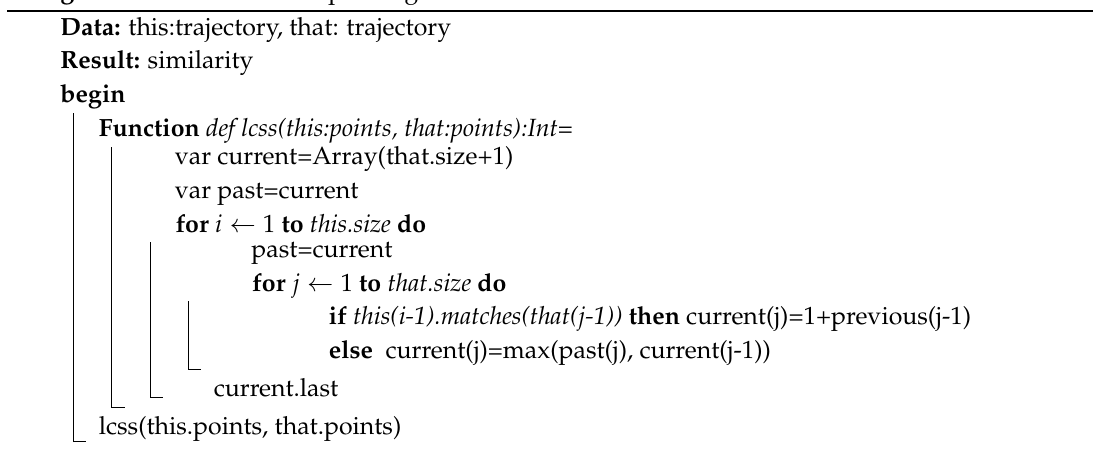
Algorithm 1: LCSS linear space